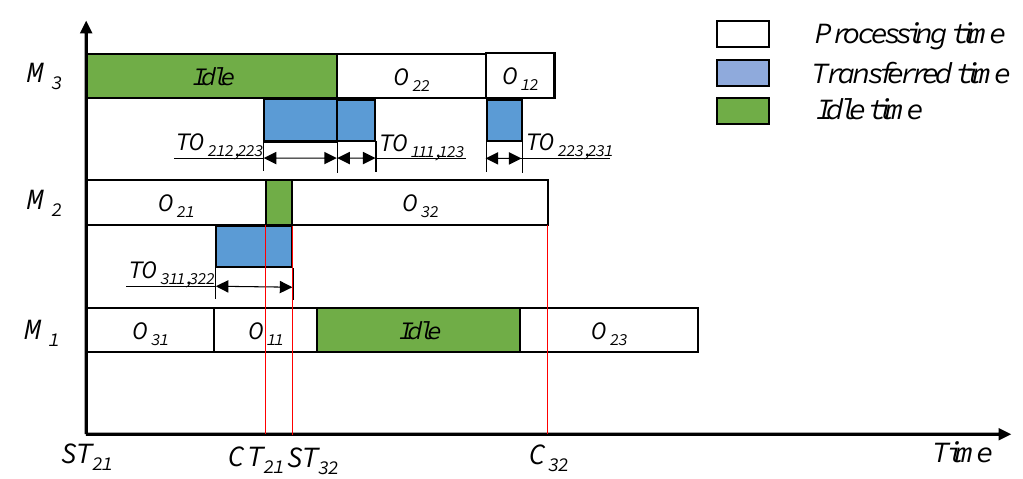
5 of 18 Table 2. Transferred times between machines (unit: min). Machine Tool Number